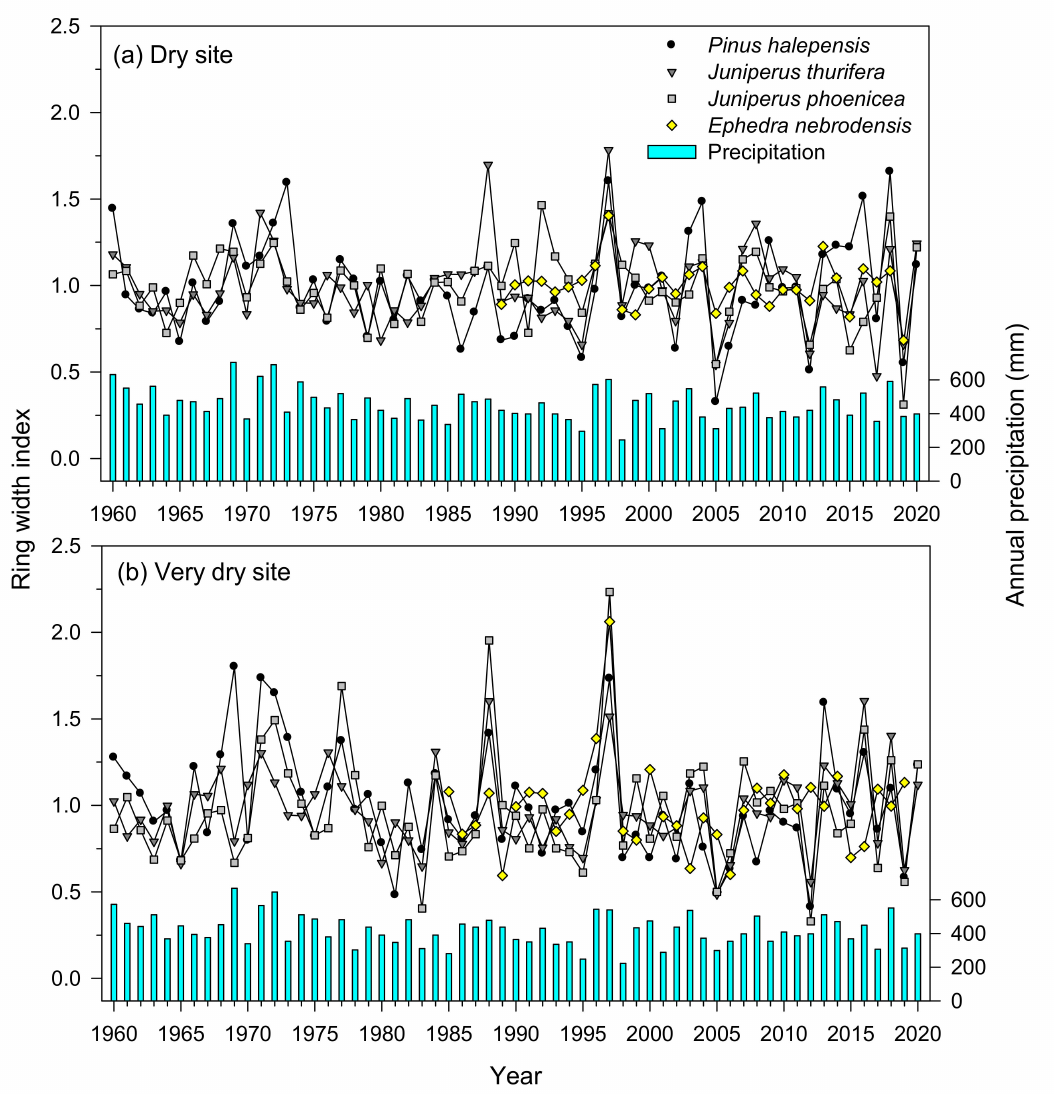
Figure 3. The interannual radial growth rates (ring width indices, residual chronologies) that were calculated for the four study species at the two study sites. The bars show the annual precipitation (right y